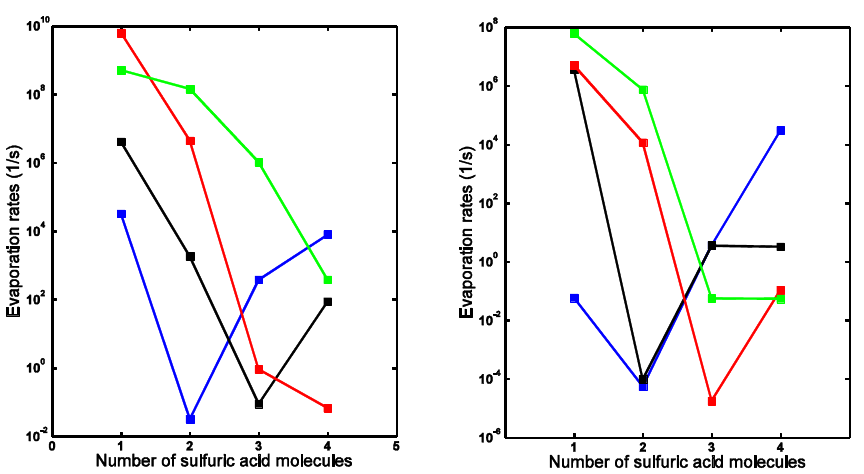
Fig. 4. Evaporation rates of different clusters versus number of sulfuric acid molecules in the cluster. The blue, black, red, and green lines represent clusters containing one, two, three, and four base molecules, respectively. The left panel is for ammonia clusters, while the right panel is for those containing DMA.